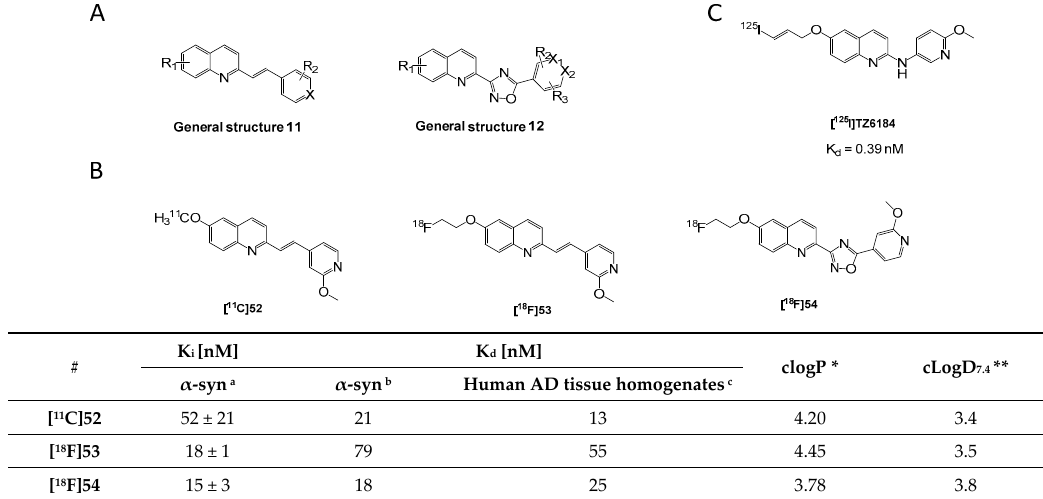
Figure 23. Chemical structures of new quinolinyl analogs. ( A ) General structures 11 and 12 of quinolinyl analogs. ( B ) Chemical structures of new radiolabeled quinolinyl analogs [ 11 C]52 , [ 18 F]53 and [ 18 F]54 . a Binding affinities expressed as K i values determined by ThT indirect competitive binding using recombinant α -syn fibrils. b Binding affinities expressed as K d values and determined by direct radioligand competitive binding using recombinant α -syn fibrils. c Binding affinities expressed as K d values and determined by direct radioligand competitive binding assay on tissue homogenates from AD patients [134]. * clogP values were calculated by BioByte. ** clogD 7.4 values calculated by ACD/Percepta. ( C ) Chemical structure of [ 125 I]TZ6184 with binding affinity K d = 0.39 nM [135].